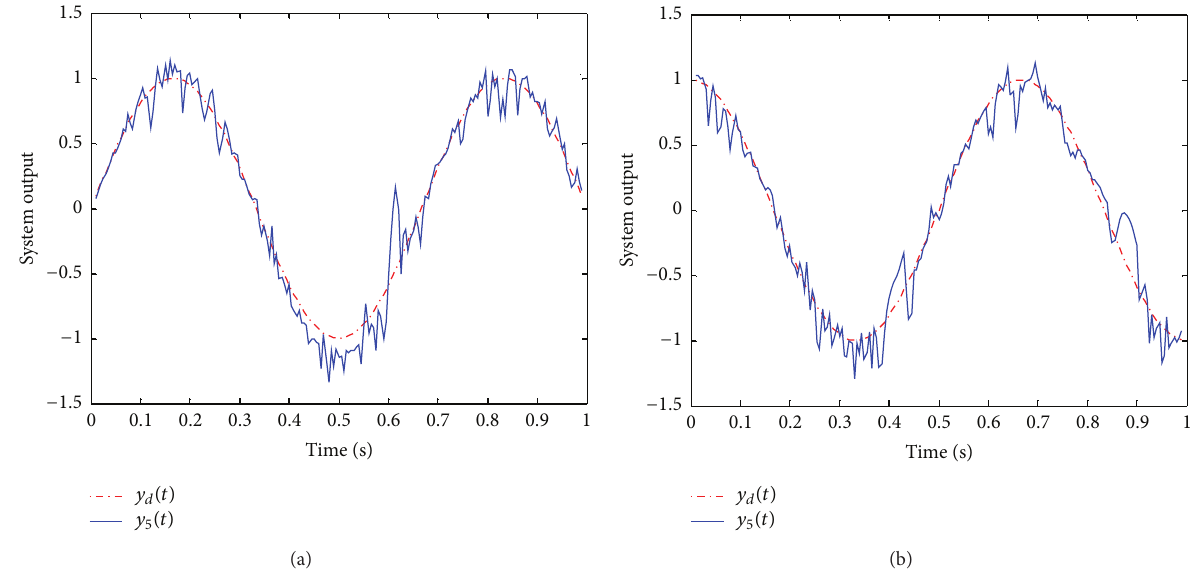
Figure 7: System output trajectory at 5th iteration for Example 2: (a) 𝑦 1,𝑘 (𝑡) , (b) 𝑦 2,𝑘 (𝑡) .